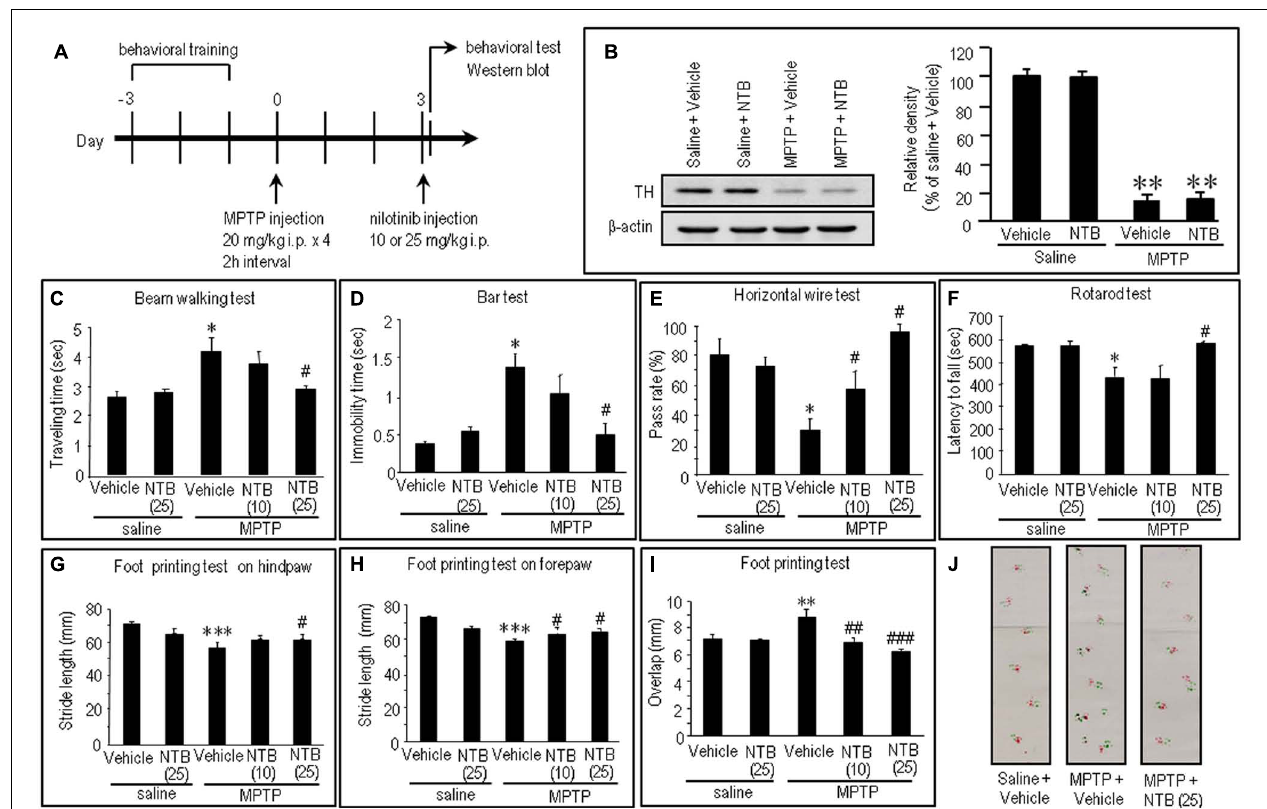
FIGURE 5 | Effects of nilotinib on MPTP-induced motor deficits in mice. (A) Experimental design. Mice were trained for behavioral tests for